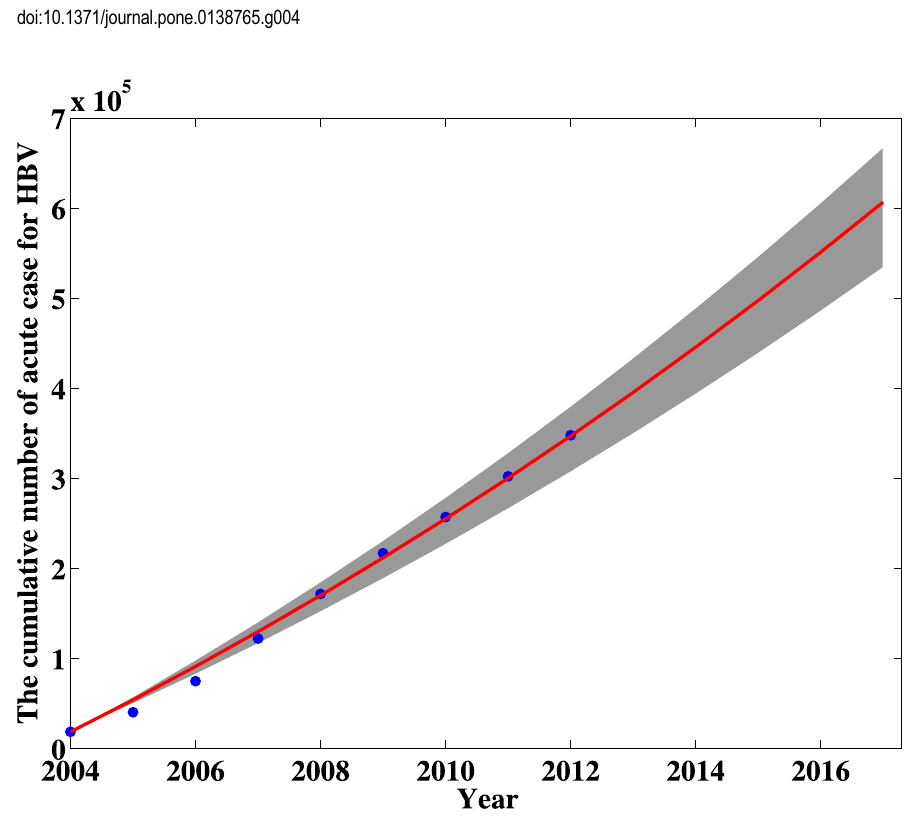
Fig 5. The tendency of the cumulative number of acute HBV cases from 2004 to 2017. Shaded areas represent 95% confidence interval around model